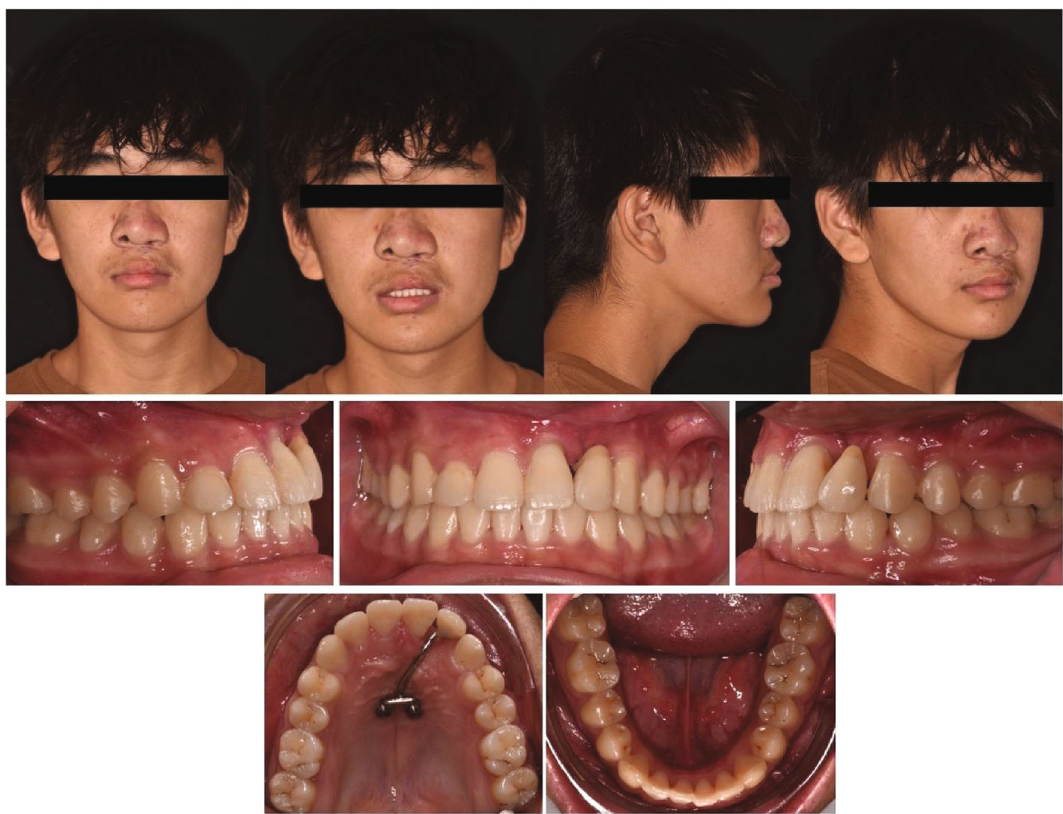
Figure 10: Final photographic documentation.